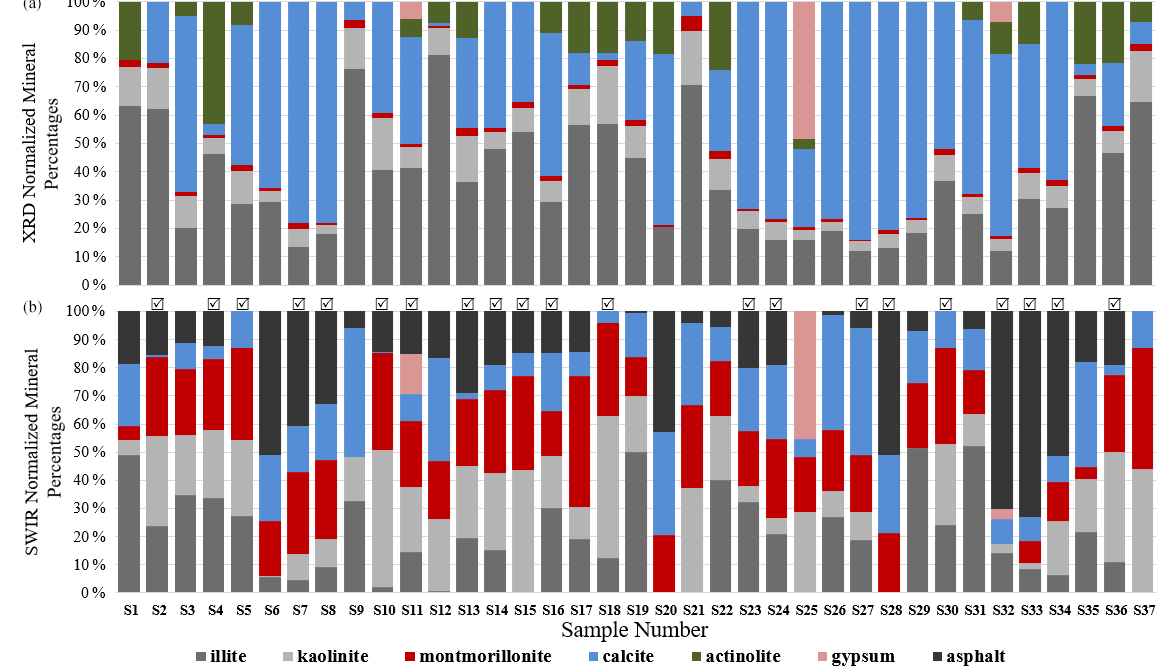
Figure 10. Bar charts show XRD (a) and SWIR (b) normalized abundances after removing the transparent minerals. Those samples with check marks had a relatively well-modeled spectral fit (e.g., Fig. 6a and b) as described in the text and are used for subsequent comparison as described in Sect.